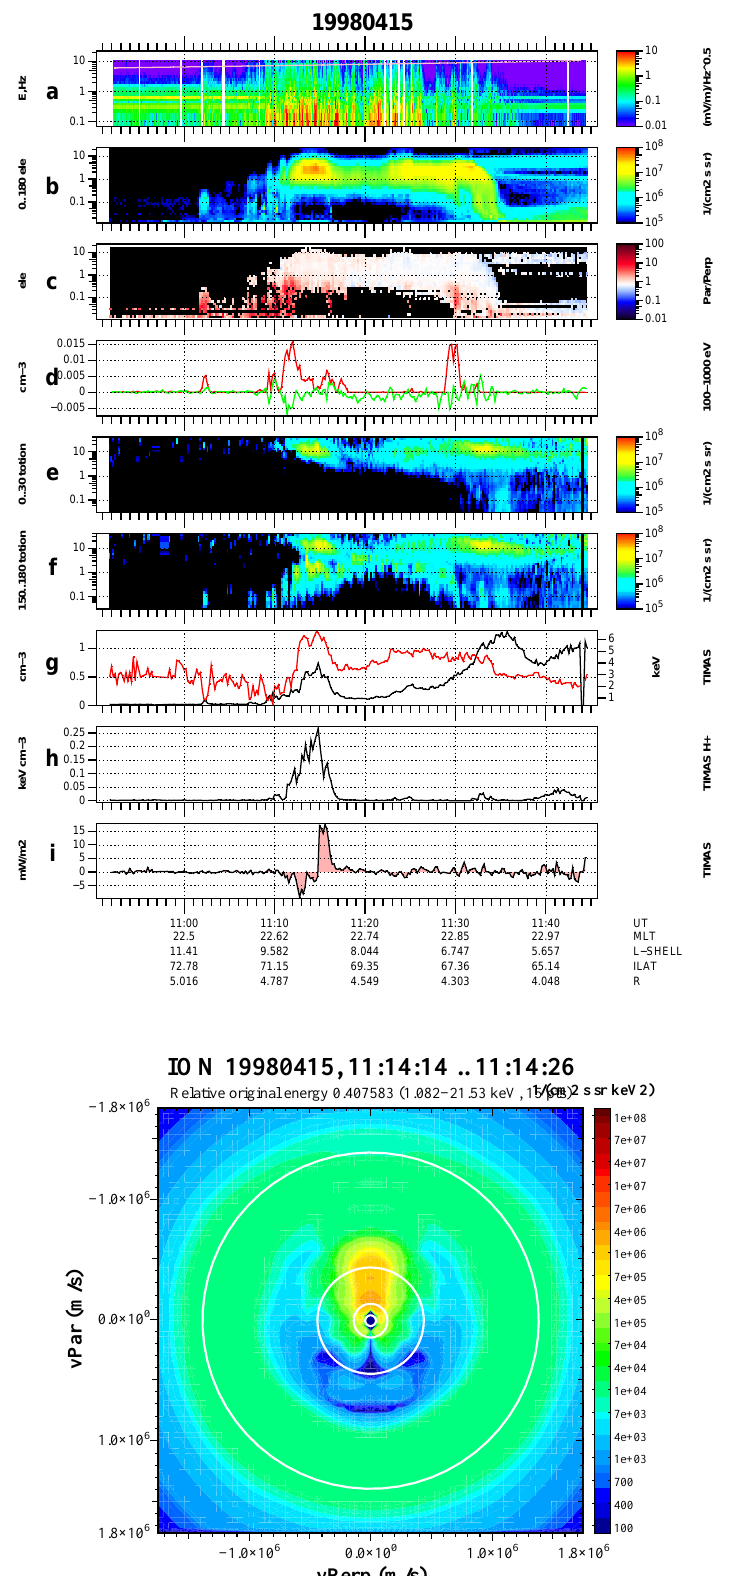
Fig. 10. Example of an event containing a 1/4-consumed shell distribution (i.e. downgoing part is intact but small pitch angles of upgoing part have been flattened out). Format is similar to Fig. 2. One-count level 100 times smaller than shell